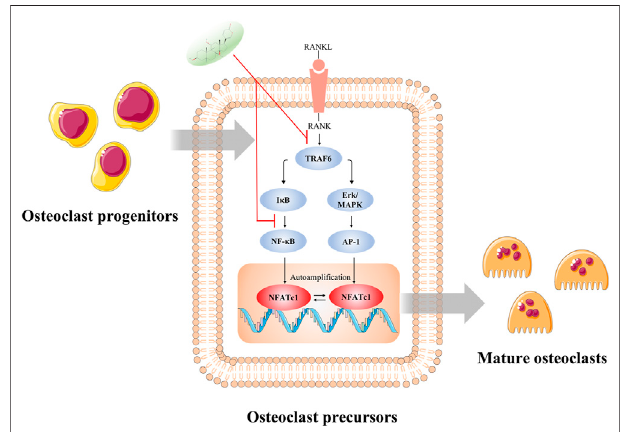
FIGURE 9 | Illustration of the potential mechanism concluded by this study. The inhibitory effect of CS-6 on functional OC formation may be in part ascribed to the inhibition of NF-kB and ERK/MAPK signaling via lessening the